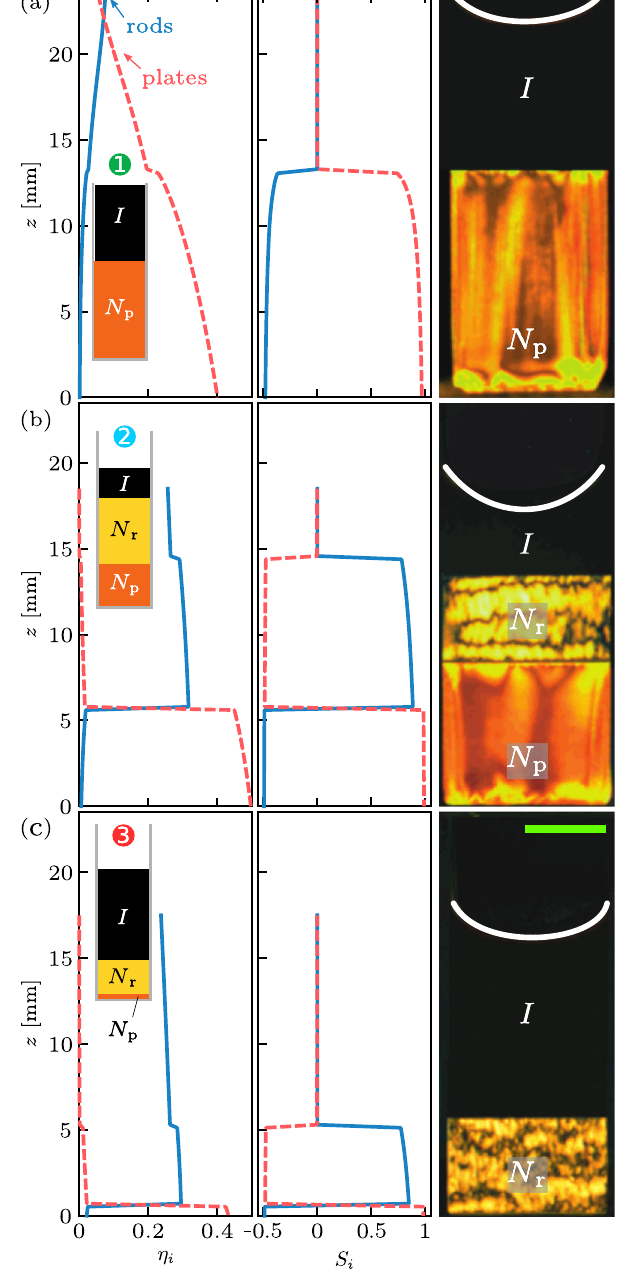
Fig. 3 Comparison with experiments. Vertical pro fi les of the packing fractions η i and the nematic order parameters S i with i = r, p for rods (solid-blue lines) and plates (dashed-red lines), respectively. Three different samples labeled as 1, 2, and 3 (indicated by the colored circles) are shown. Schematics of the samples showing the isotropic ( I ), nematic rod-rich ( N p ) and nematic plate-rich ( N p ) layers are represented in the ; (cid:1) η insets. The average packing fractions ( (cid:1) η ) are (0.027, 0.24) ( a ), r p (0.20, 0.16) ( b ), and (0.25, 0.025) ( c ). The corresponding experimental samples (pictures taken between crossed polarizers) by van der Kooij and Lekkerkerker 22,23 are also shown (adapted with permission 23 , Copyright 2000 American Chemical Society). The meniscus is highlighted with a white line. The bright areas are due to light being polarized in layers with orientational order. The scale bar (green) is 5